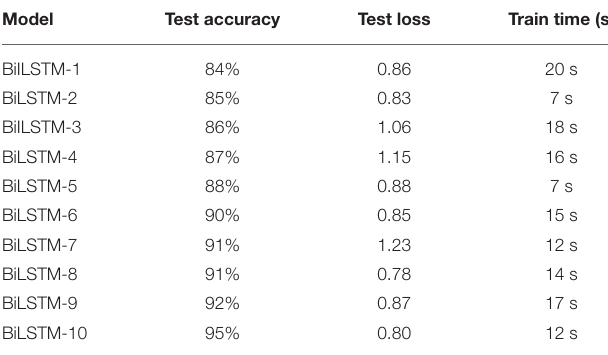
TABLE 2 | Accuracy, test loss, and training time of the BiLSTM models.